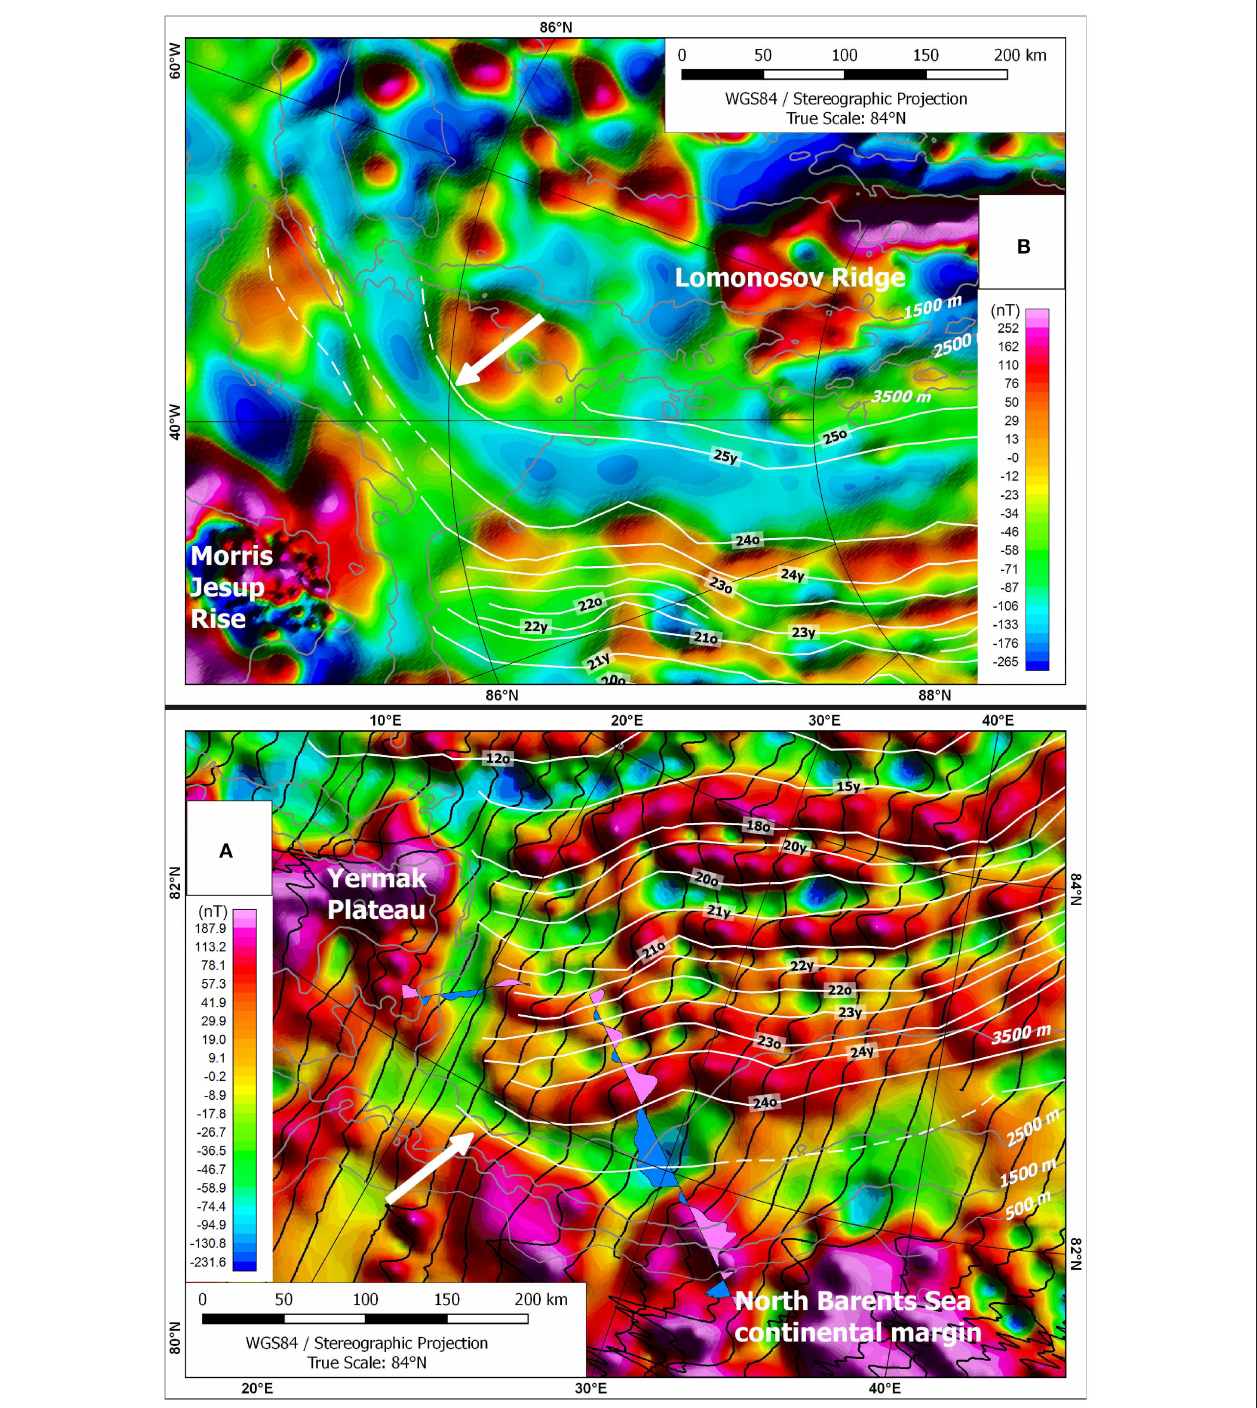
FIGURE 2 | Magnetic anomaly maps of the western Eurasian Basin with superimposed anomaly interpretation from Brozena et al. (2003, white lines). White arrows indicate the northward bending of anomalies C25? and C24, gray lines the bathymetry from the IBCAO dataset ( Jakobsson et al., 2012). (A) Newly gridded aeromagnetic line data (US Naval Research Laboratory Arctic surveys 1998/99, Brozena et al. (2003), downloaded from NCEI/NOAA) and raw data used for gridding (black wiggle traces). Also shown are the magnetic data measured along lines BGR13–207 and –208 as filled wiggle traces (see also Figure 3B ). (B) Data from the CampGM compilation (Gaina et al.,